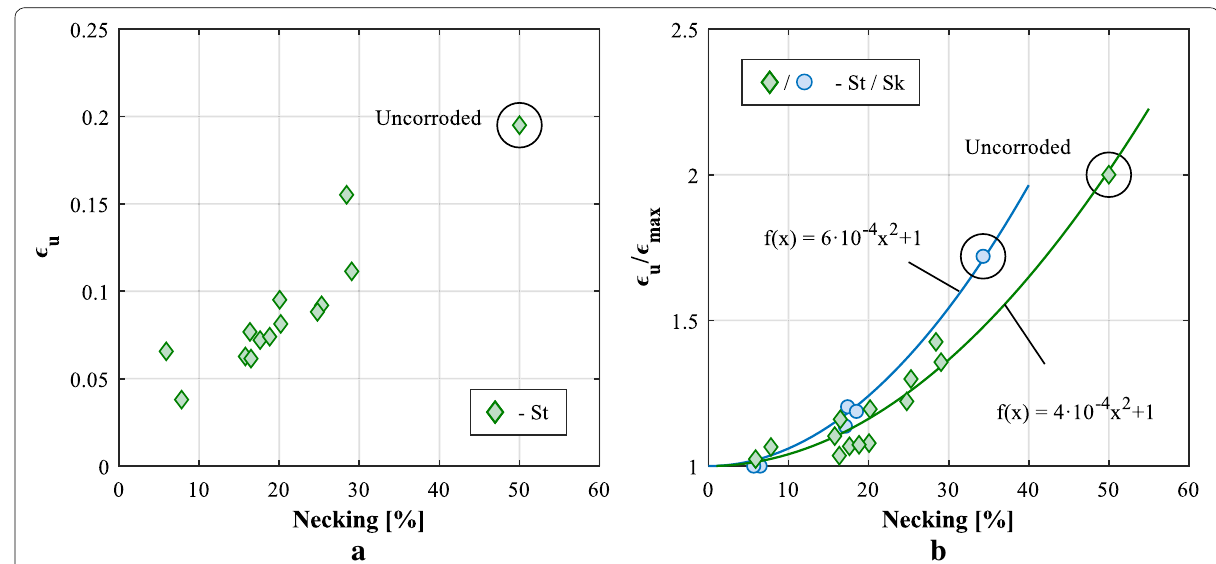
Fig. 16 Relations between strains and the measured necking at failure. a Strain at failure and b ratio strain at failure to strain at maximum load